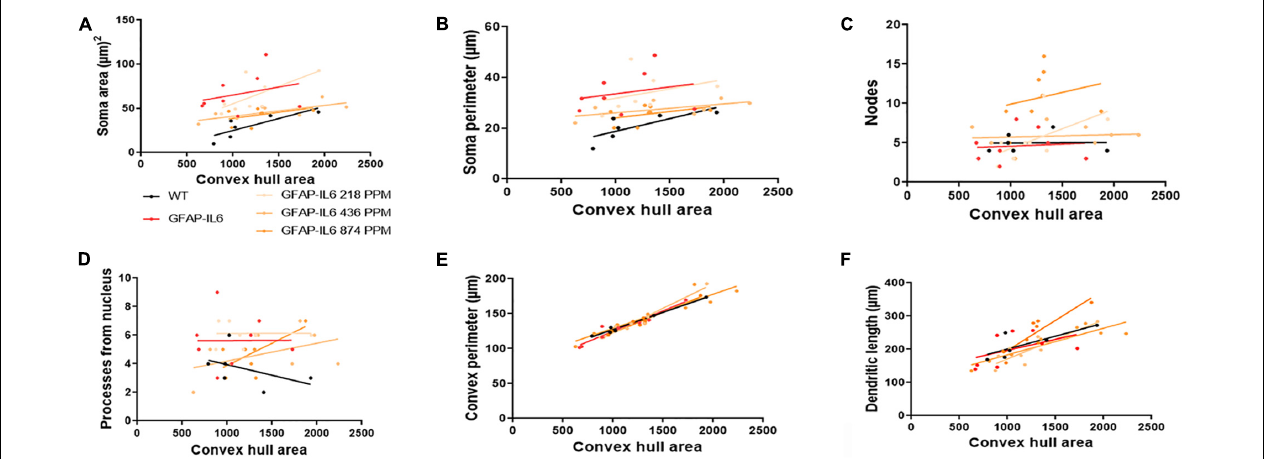
FIGURE 12 | Bivariate correlation: MC effects on morphology are dose-independent in the hippocampus. (A–F) Different morphological parameters have been plotted against convex hull area to see the bivariate correlation between WT, GFAP-IL6 and between non-treated and treated ones. We found that the convex perimeter of both wild type and GFAP-IL6 are significantly correlated, whereas treatment with any dose of MC showed significant correlation of convex perimeter and dendritic length relative to convex hull area in the hippocampus. ANCOVA and sum-of-squares tests.